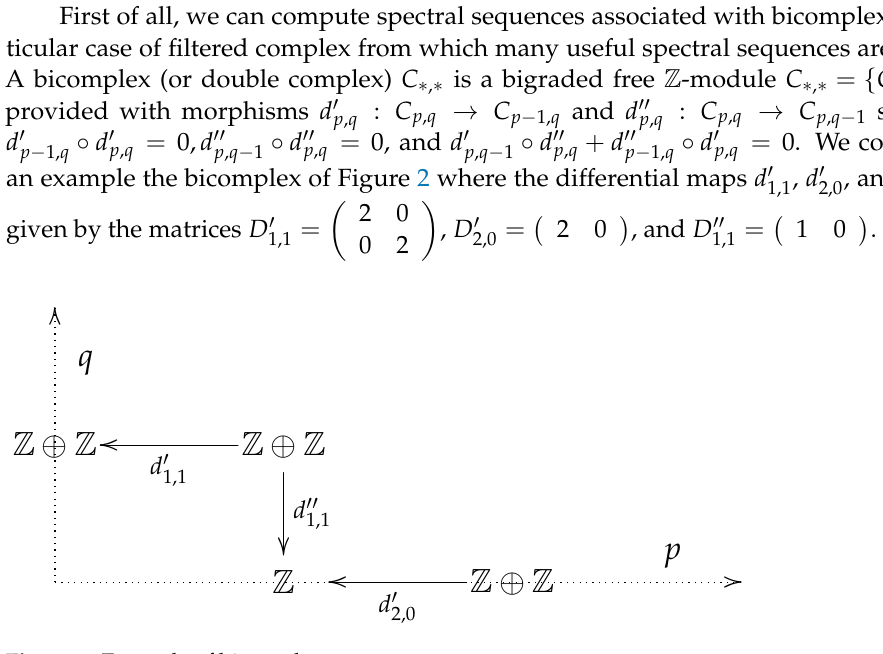
Figure 2. Example of bicomplex.